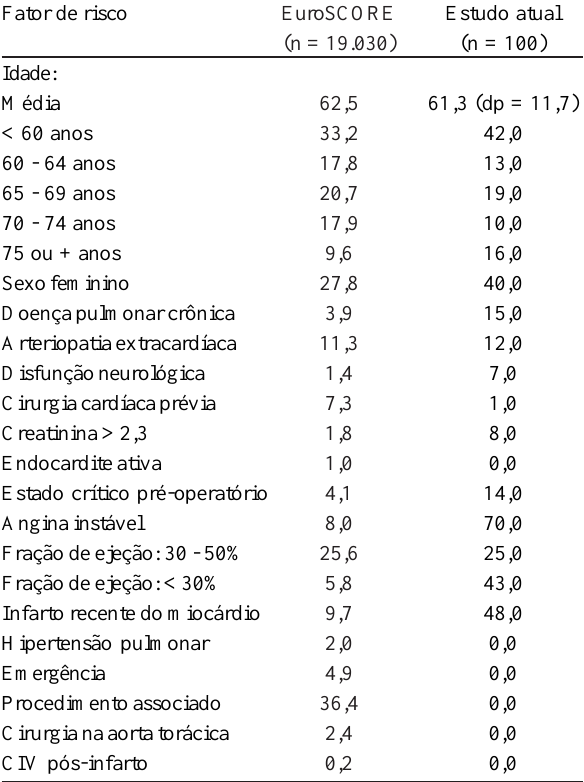
Tabela 2. Prevalência de fatores de risco nas casuísticas do EuroSCORE e no estudo